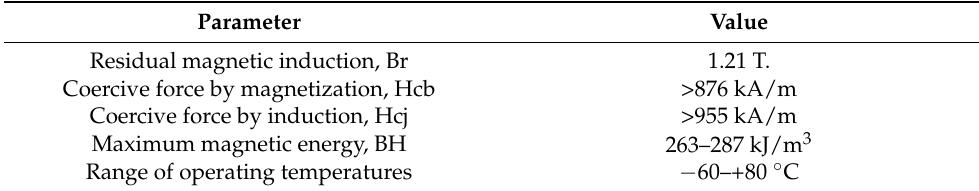
Figure 3. Test sample general view. Type III. Table 1. Main magnetic properties of NdFeB magnetic Table 2. Dimensions of the samples for research.